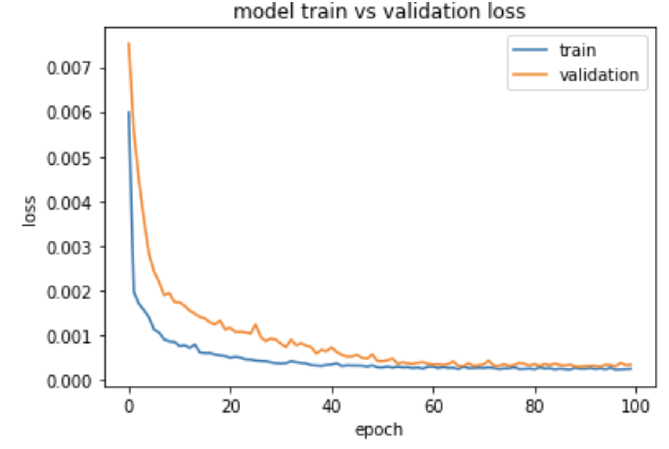
Figure 6. Training error and validation error after 100 epochs (source: authors’ calculations).